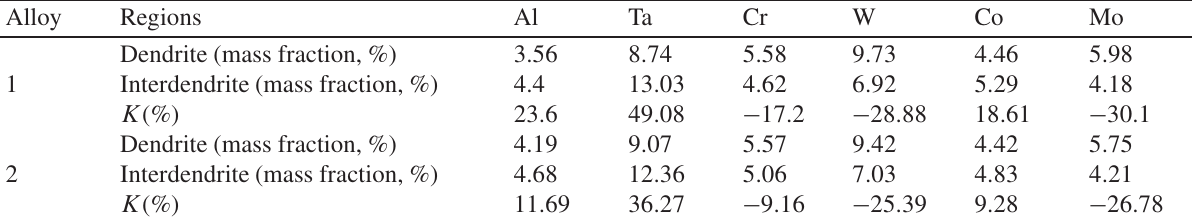
Table 1. Distribution and segregation coefficients of the elements in the interdendrite/dendrite regions of the as-cast al- loys.